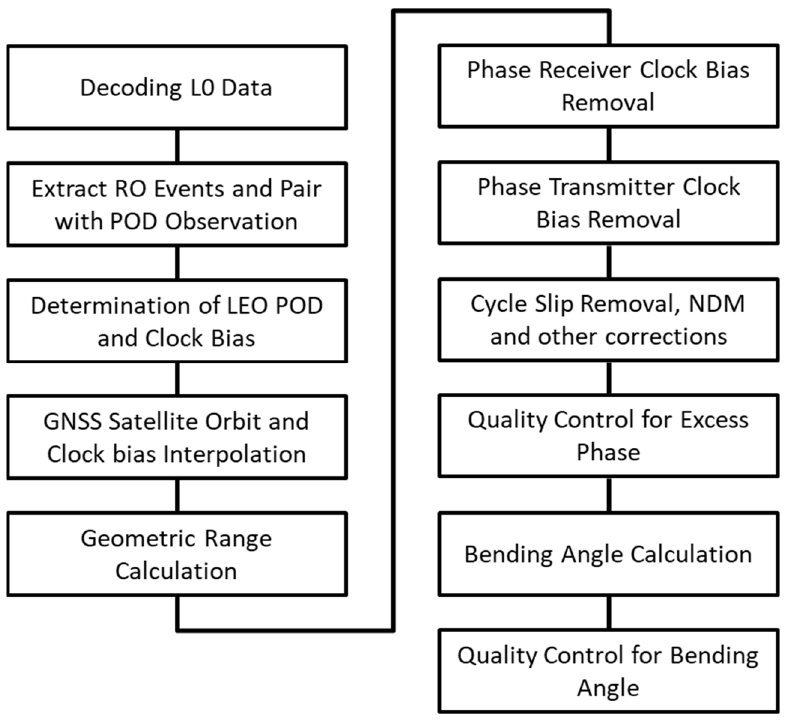
Figure 1. The steps to convert RO from L0 data to L1 excess phase and converting excess phase to bending angle (L2) processing. bending angle (L2)